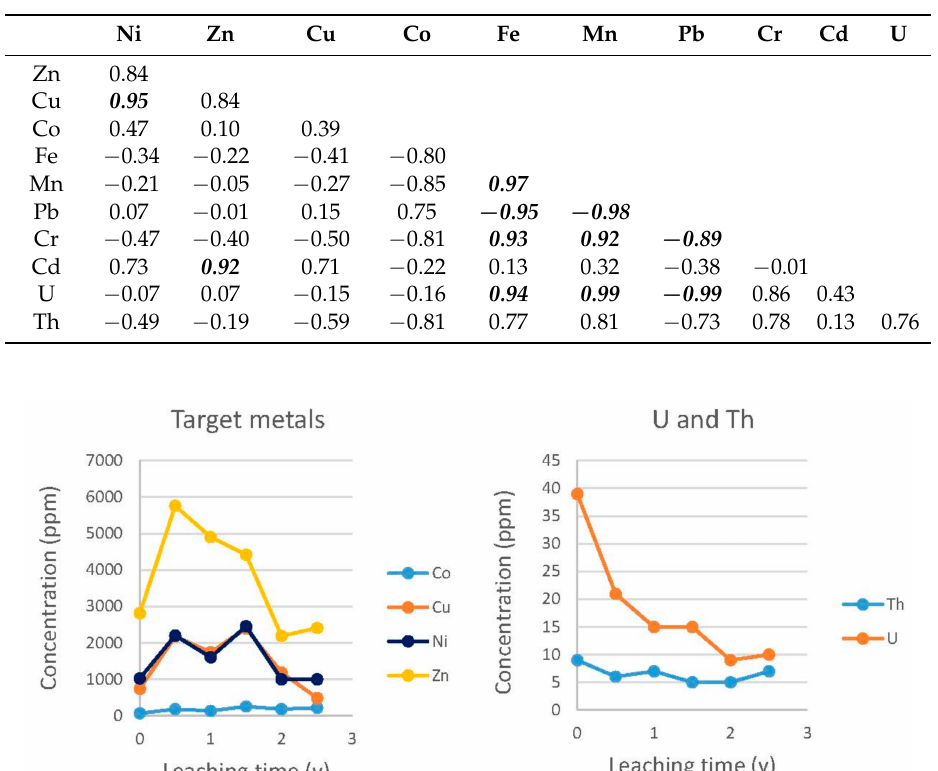
Table 4. Pearson correlation coefficients for metals in the Talvivaara leaching heaps. Values having statistical significance (two-tailed p < 0.05) are in bold.